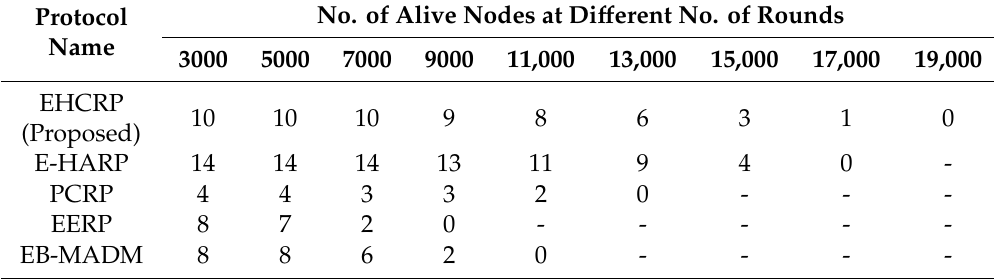
Figure 8. Breakdown of Live Nodes vs. Rounds. Table 5. Live nodes vs.